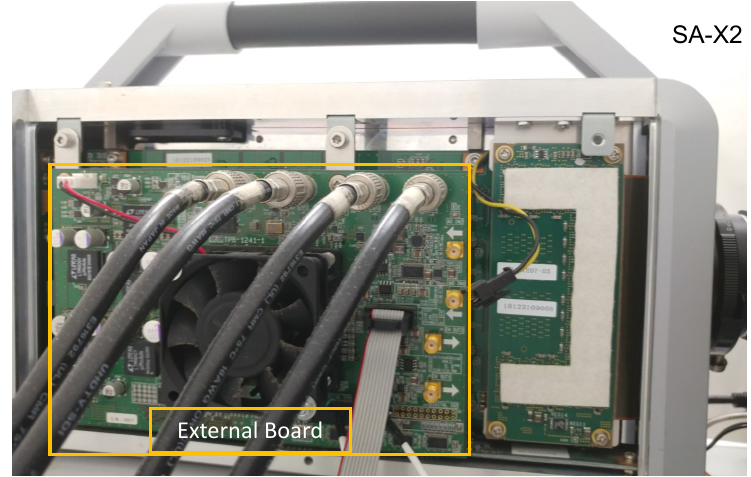
Figure 1. Overview of the FASTCAM SA-X2 with the embedded external board.